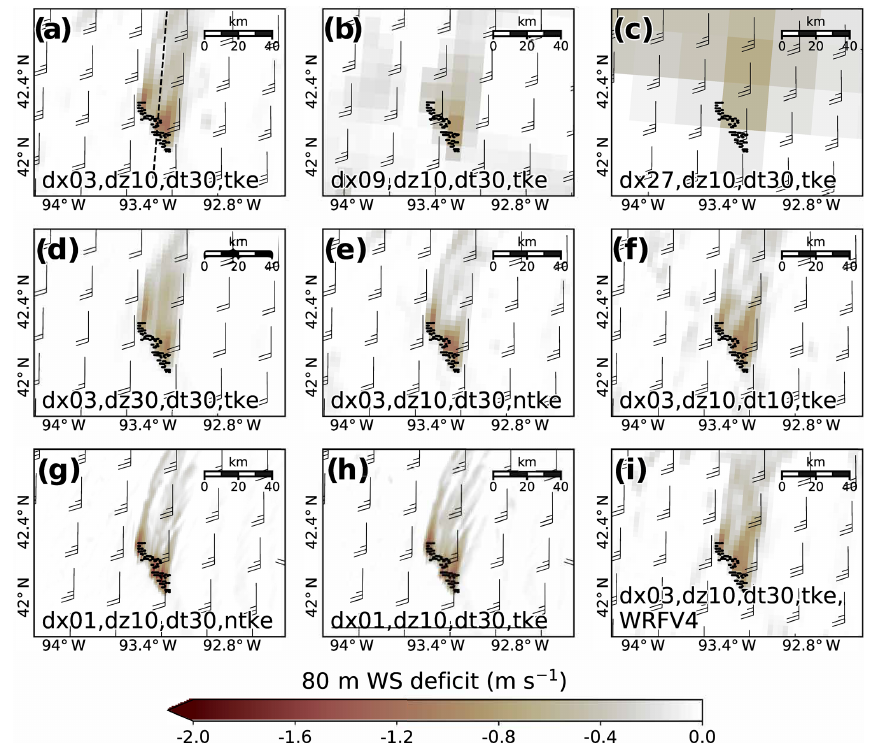
Figure 6. Hub-height ( ∼ 80m) wind speed (WS) deficits resulting from the presence of the wind farm in the tested simulations on 26 August 02:00UTC (25 August 21:00LT). The 80m wind barbs from the wind farm simulation are plotted in knots every 27km, regardless of horizontal resolution. The dashed line in panel (a) denotes the location of the vertical cross section in Fig. 11. Panels are cropped to the same region around the wind farm despite certain configurations having varying simulation domains depending on horizontal